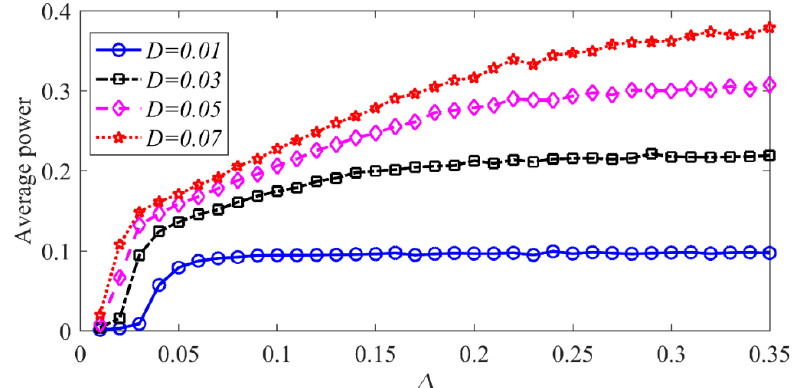
Figure 10. Influence of center frequency on the output performance of the asymmetric MEH excited by band-limited noise with different noise intensity ( Δ = 0.05).